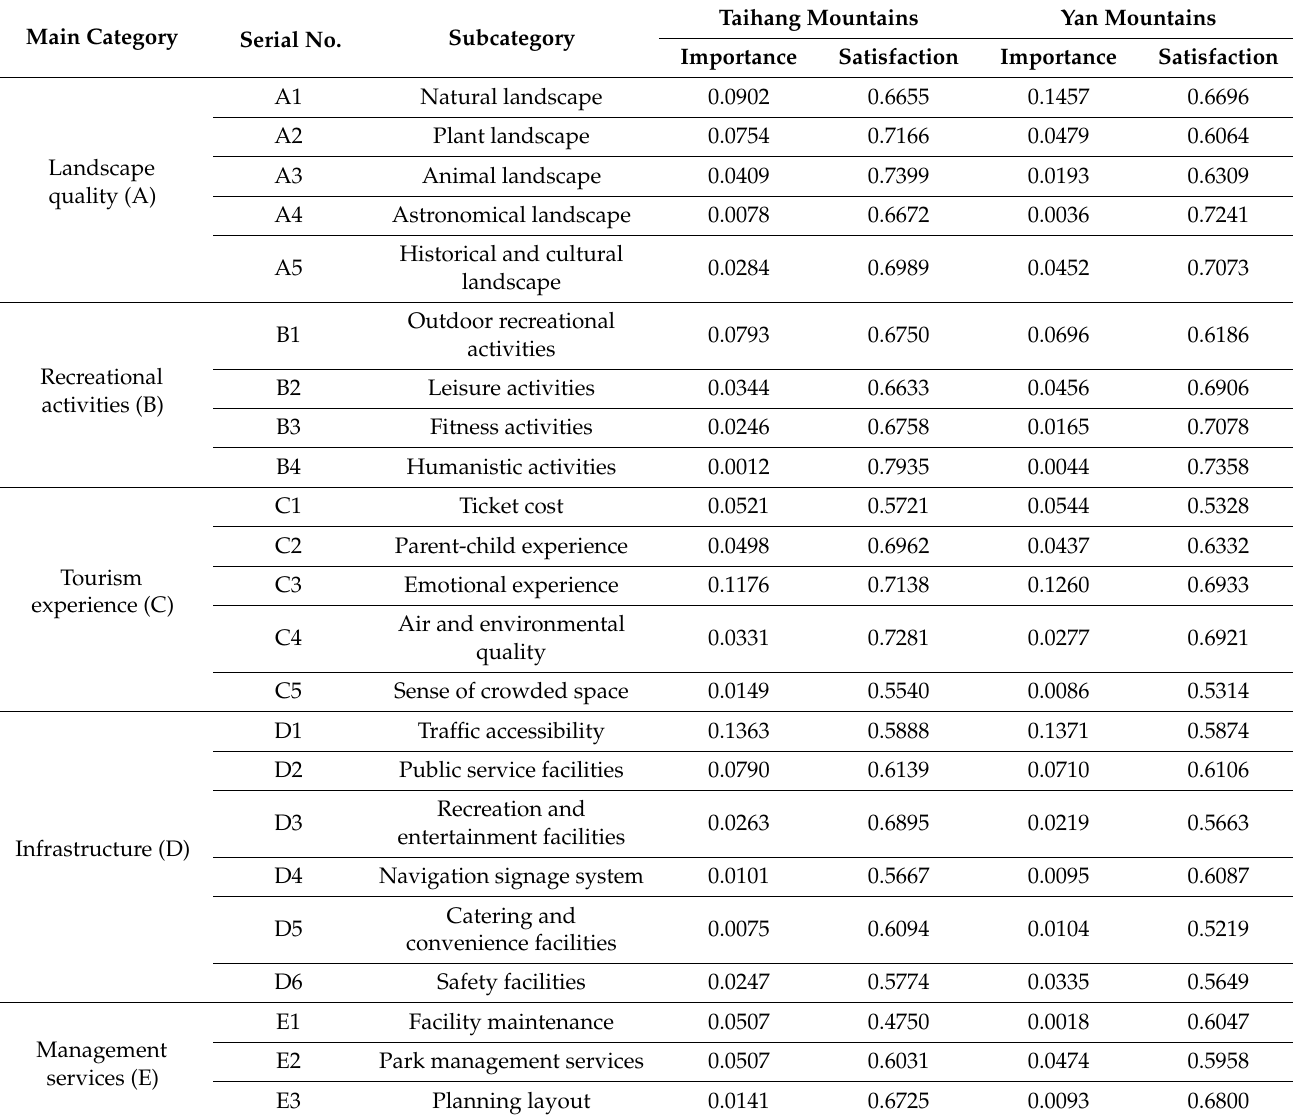
Table 10. Importance and satisfaction scores of tourists’ satisfaction in terms of recreation in different mountain